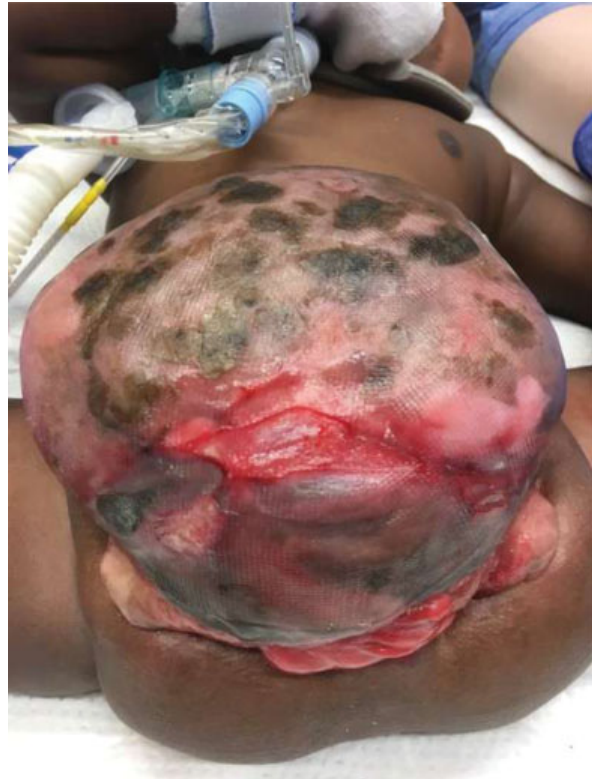
Fig. 4 Twelve months old: After alloderm patch has re-epithelialized. Bladder plates and bowel on inferior aspect of